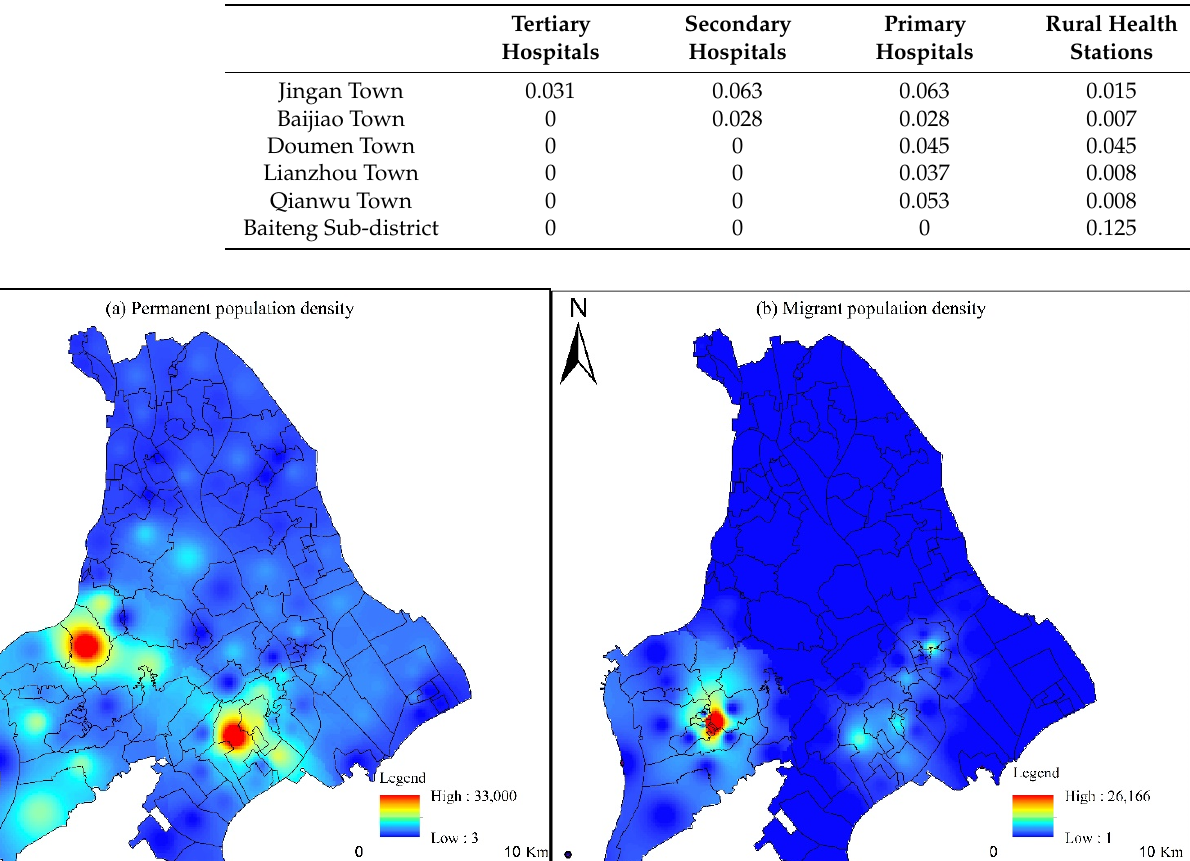
Table 3. Gini coefficient table of multi-level public health facilities in Doumen District of Zhuhai (Guangdong Province), China, 2020.